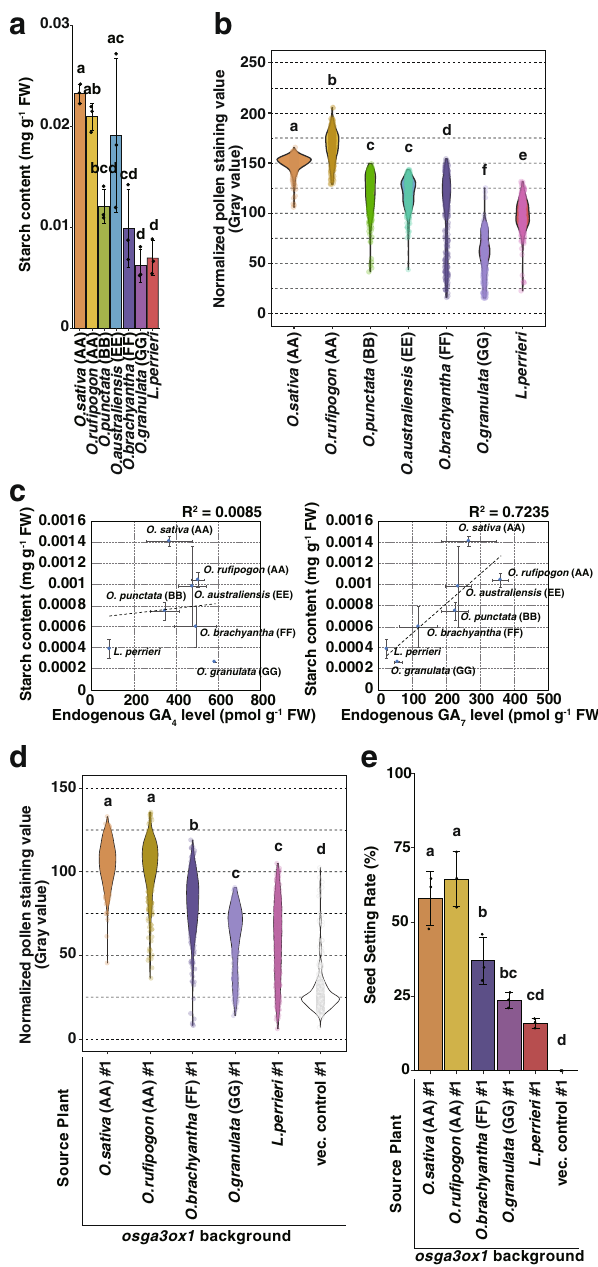
Fig. 5 Effects of GA3ox1 on pollen and seed fertility in Oryza species and L. perrieri . a Endogenous quantities of starch in Oryza species and L. perrieri anthers. Error bars, s.d. n = 3, one-way ANOVA with Tukey ’ s multiple comparisons test. Different letters denote signi fi cant differences ( p < 0.05). b Quanti fi cation of the staining value of KI-stained Oryza species and L. perrieri pollen. n = 300 pollen grains for each species, statistical analysis as mentioned in panel ( a ). c Correlation between starch content and endogenous gibberellin levels in Oryza species and L. perrieri anthers. The coef fi cient of determination ( R 2 ) is shown on the upper right side of the plot. The respective values are 0.0085 between starch content and GA 4 levels (left panel), and 0.7235 between starch content and GA 7 levels (right panel). d Quanti fi cation of the staining value of KI-stained pollen grains of transgenic plants described in Supplementary Fig. 12a and vector control. n = 300 pollen grains for each line; statistical analysis as mentioned in panel ( a ). e Seed setting rate of transgenic plants described in Supplementary Fig. 12a and vector control. n = 3 panicles for each line; statistical analysis as mentioned in panel (